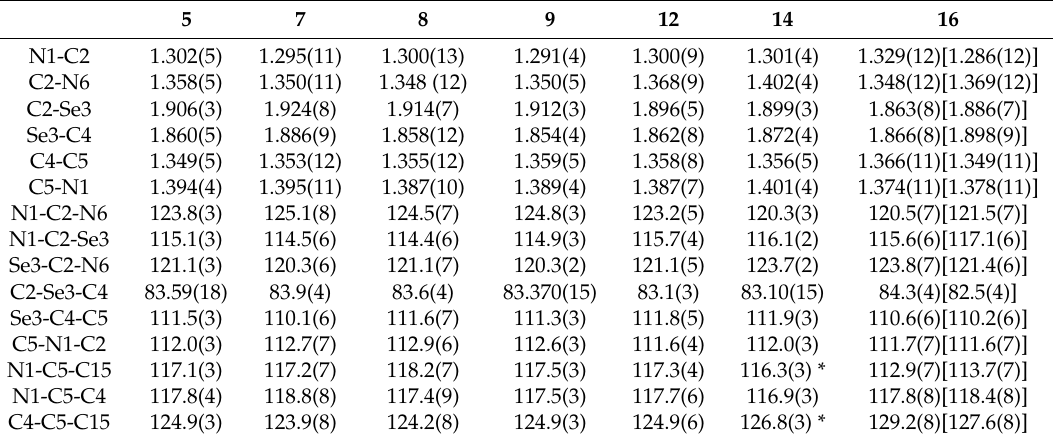
Table 4. Selected Bond Distances (Å) and Angles ( ◦ ) for Compounds 5 , 7 , 8 , 9 , 12 , 14 and 16 .